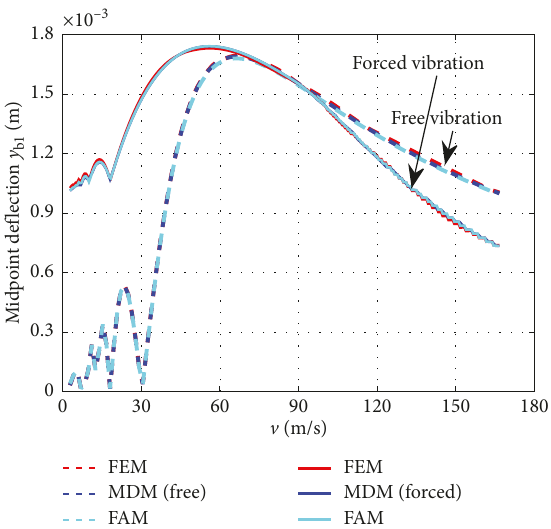
Figure 6: Maximums of the bridge vibration response versus different speeds.